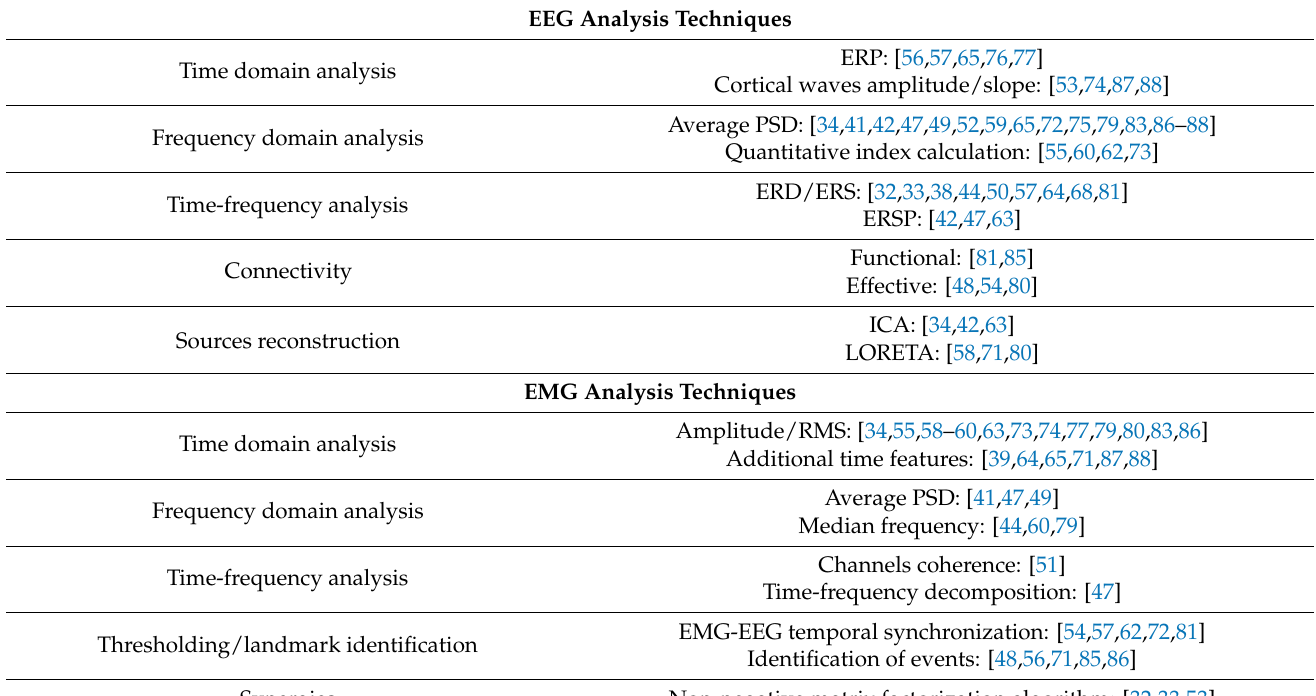
Table 5. Signal analysis